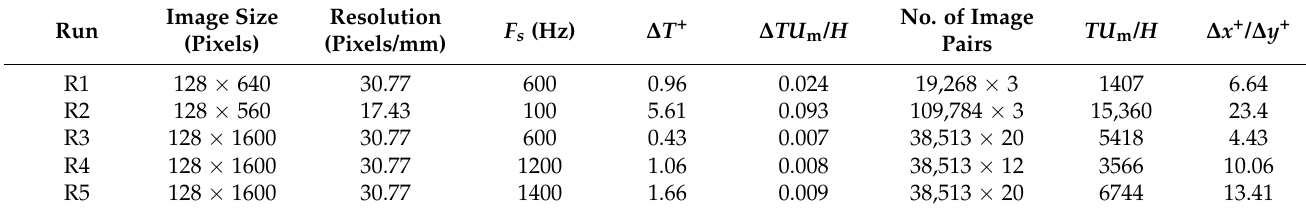
Table 2. PIV parameters (b)